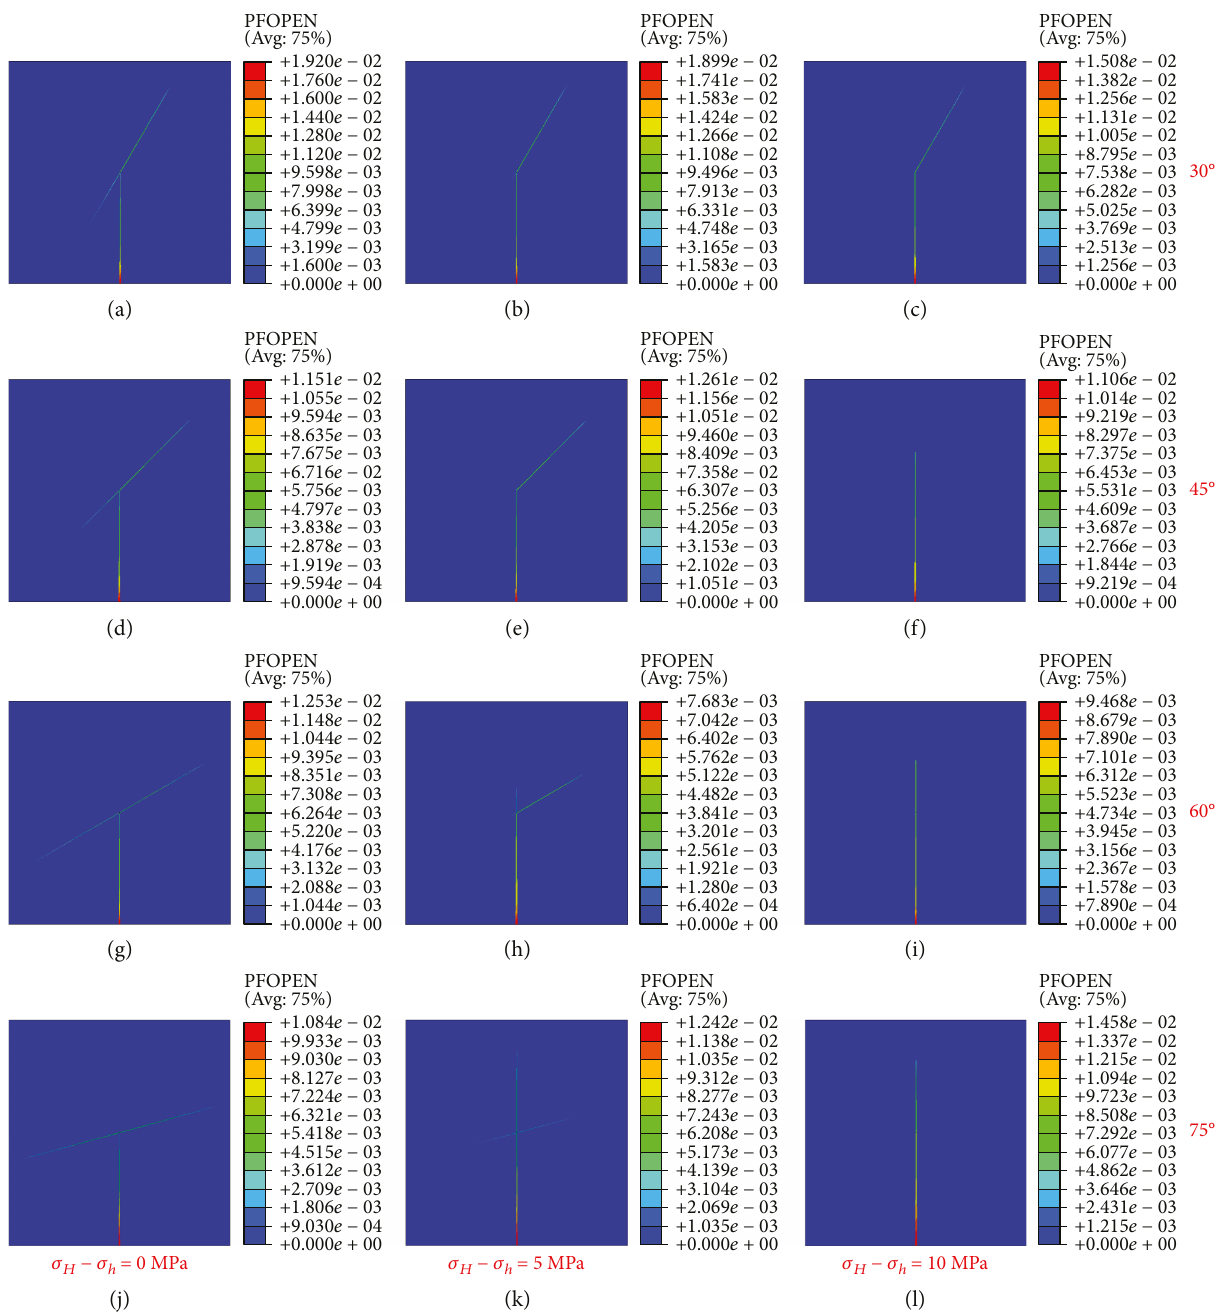
Figure 5: In fl uence of the approaching angle and in situ horizontal stress di ff erence on arti fi cial fracture propagation